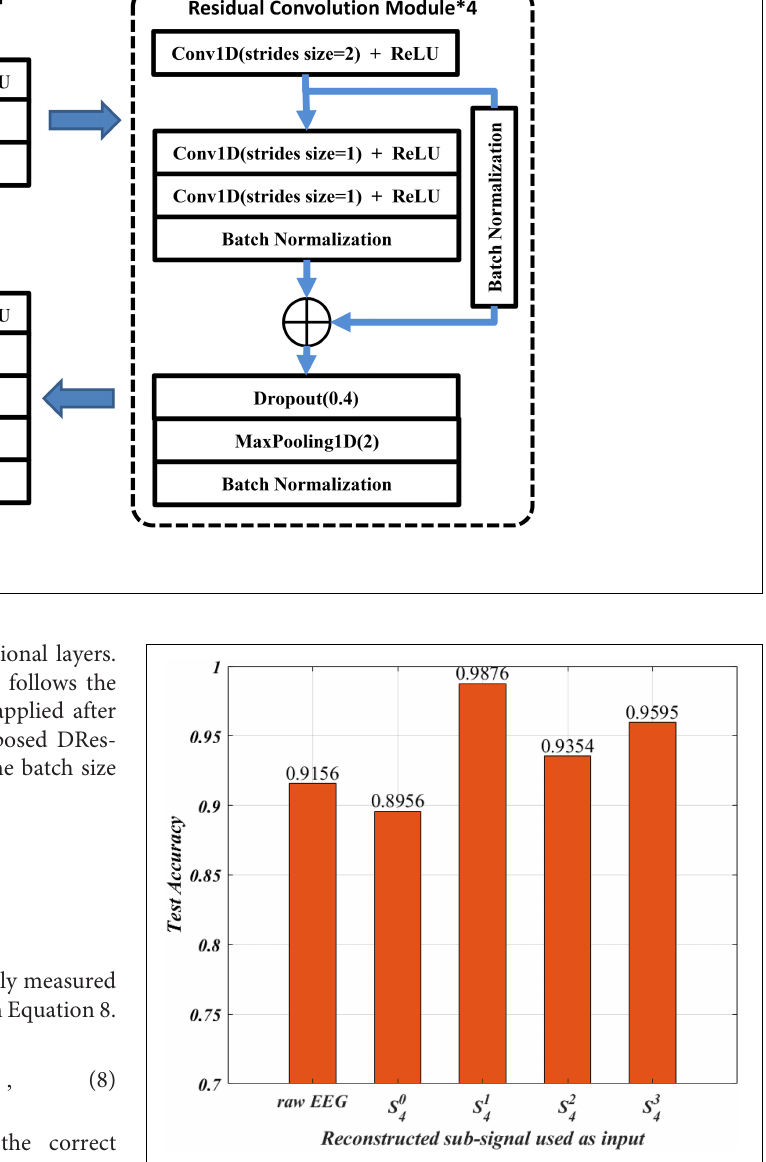
FIGURE 4 | Comparison of average test accuracy by different reconstructed